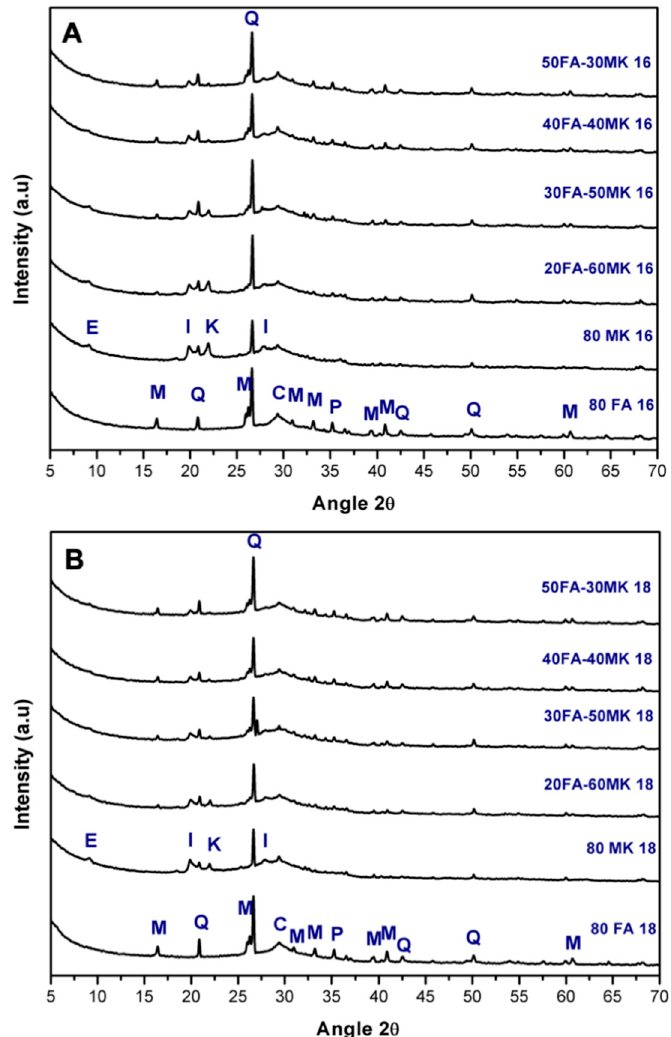
Figure 2. X ‐ ray diffraction patterns of the systems cured for 90 days of: ( A ) activator with 16% Na 2 O and ( B ) activator with 18% Na 2 O. Crystalline phases observed: Q: Quartz, M: Mullite, K: Cristobalite, P: Portlandite, I: Illite, E: Ettringite, C: